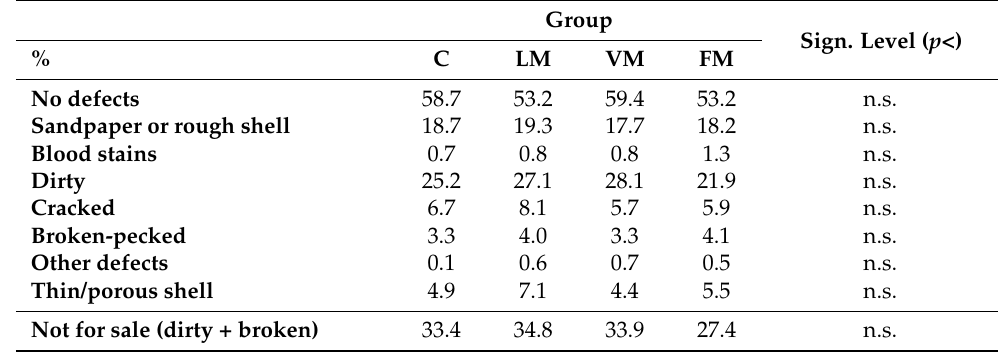
Table 4. Egg defects (expressed as a percentage) across the entire trial (C = Control, LM = Longitudinal Movement, VM = Vertical Movement, FM = Freedom of Movement). Significance is assessed across groups, timepoints and tiers. At each timepoint, two aviaries per group were assessed (180 eggs sampled per aviary, of which 60 from each tier).